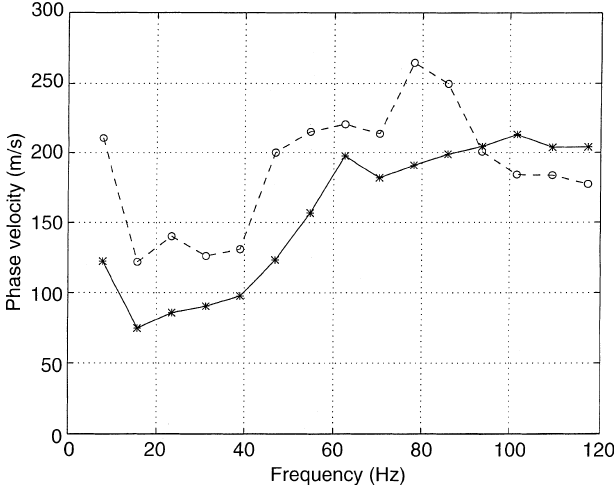
Fig. 10. The phase velocity as a function of frequency obtained from the cross-phase spectrum. Solid line refers to upleg conditions, dashed line to downleg. The data are obtained for an altitude interval of approximately 2 km, centered around 102 km